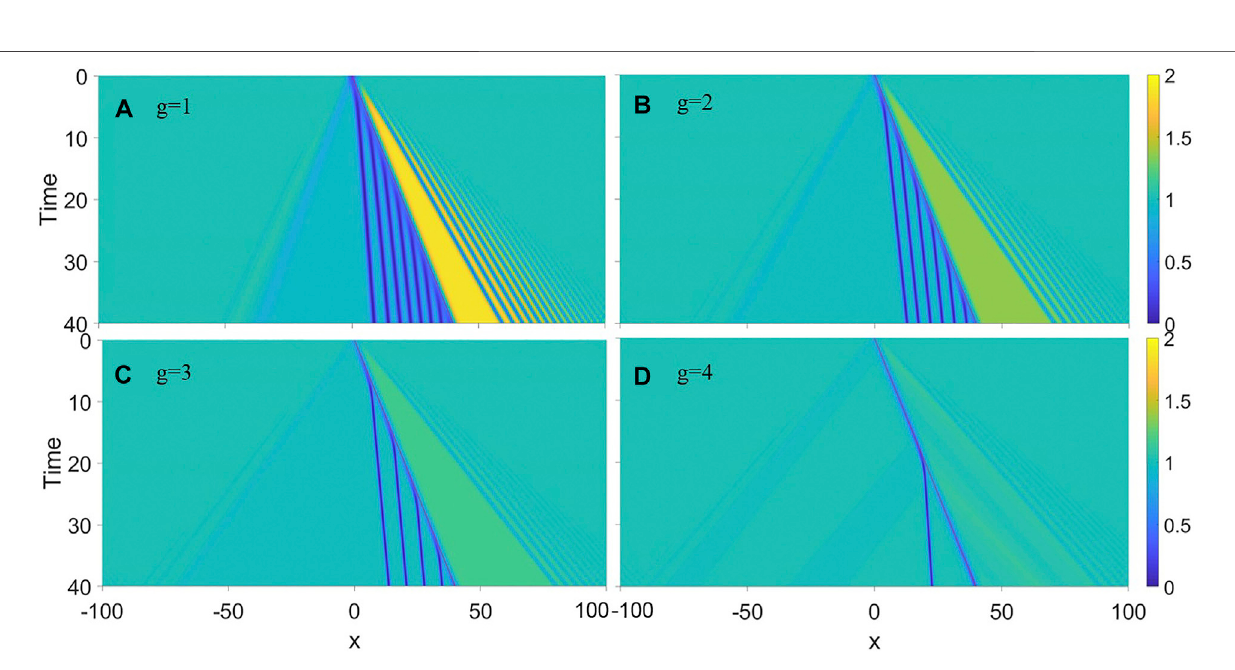
leftwards instead of rightwards. As the obstacle speed increases to v (cid:2) 1.2, more solitons are emitted and the solitons begin to move rightwards.